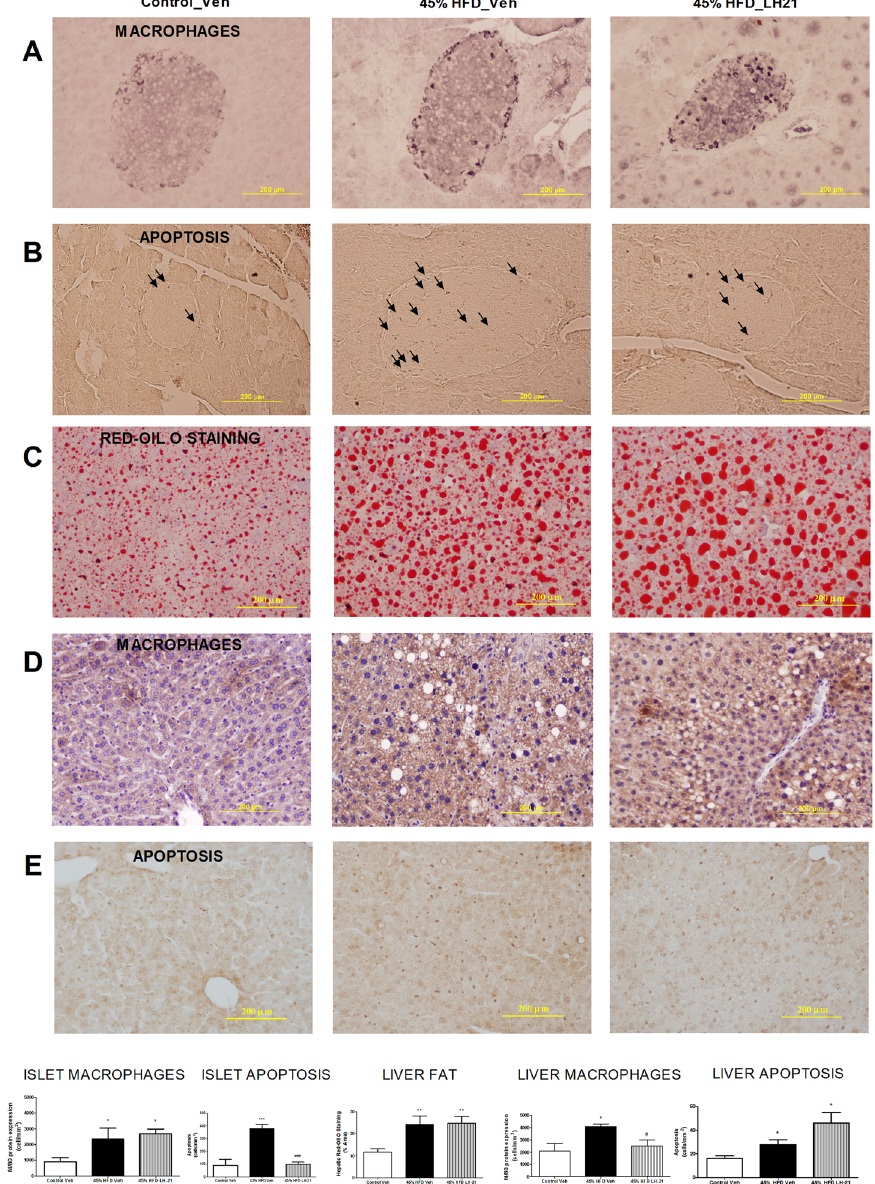
Figure 3. Effects of LH-21 in the islets of Langerhans and the liver. ( A ) Macrophage infiltration in the islets was assessed by immunohistochemistry with the specific marker F4/80. Quantification of immunostaining within islets revealed increased macrophage infiltration in 45% HFD mice, with no differences between vehicle- and LH-21-injected mice. The images are representative of islets from four mice each group and four different sections from each pancreas; one-way ANOVA and Bonferroni’s post-test, * p < 0.05 versus control. ( B ) Apoptosis in islet cells was assessed by a specific apoptosis kit. The number of apoptotic cells was increased in islets from 45% HFD- vehicle mice, while there was no increased apoptosis in islets from 45% HFD-LH-21 mice when compared to control mice. ( C ) Fat accumulation in the liver was studied by red-oil O staining of hepatic sections. Quantification of this specific marker revealed increased fatty content in the liver of 45% HFD mice, both vehicle- and LH-21- injected mice. ( D ) Macrophage infiltration in the liver was assessed by immunohistochemistry with the specific marker F4/80. These sections were counterstained with haematoxylin. Quantification of immunostaining in the liver revealed increased macrophage infiltration in 45% HFD-vehicle when compared to control-vehicle mice, but no increase was detected in 45% HFD-LH-21 mice. ( E ) Apoptosis in the liver was assessed by a specific apoptosis kit. The number of apoptotic cells was increased in the livers of both 45% HFD-vehicle and 45% HFD-LH-21 mice when compared to control-vehicle mice. ( A , B ) The images are representative of islets from four mice in each group and four different sections from each pancreas; one-way ANOVA and Bonferroni’s post-test, *** p < 0.001 versus control, ### p < 0.001 versus 45% HFD-vehicle. (C-E) The images are representative of livers from four mice in each group and four different sections from each liver; one-way ANOVA and Bonferroni’s post-test, * p < 0.05, ** p < 0.01 versus control-vehicle, # p < 0.05 versus 45%